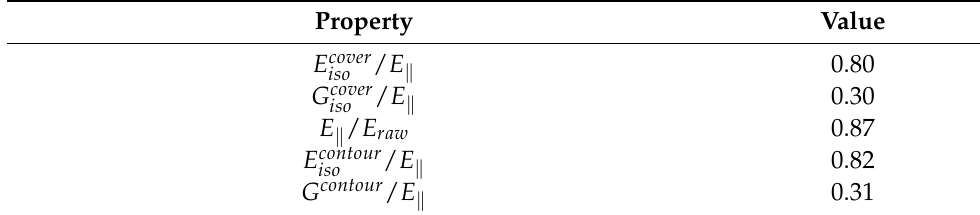
Table 7. Non-dimensional relationships for adhesion-independent mechanical